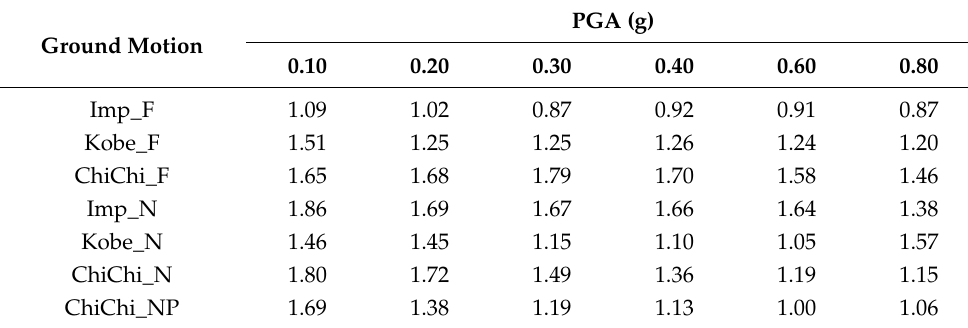
Table 7. Amplification factors of the roof acceleration.